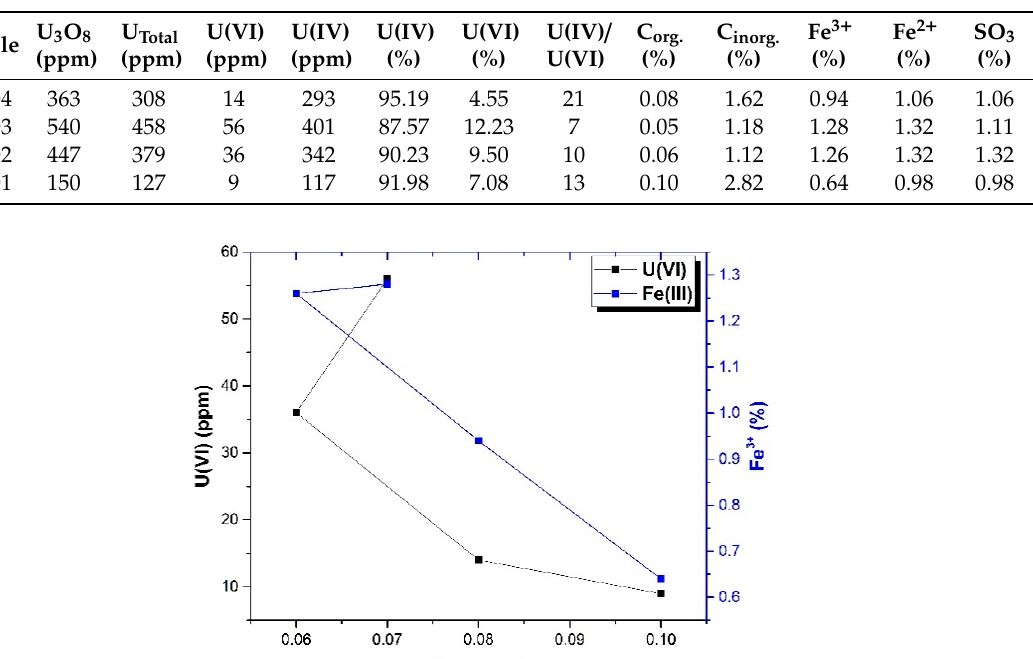
Table 7. Special characteristics of uranium ore.